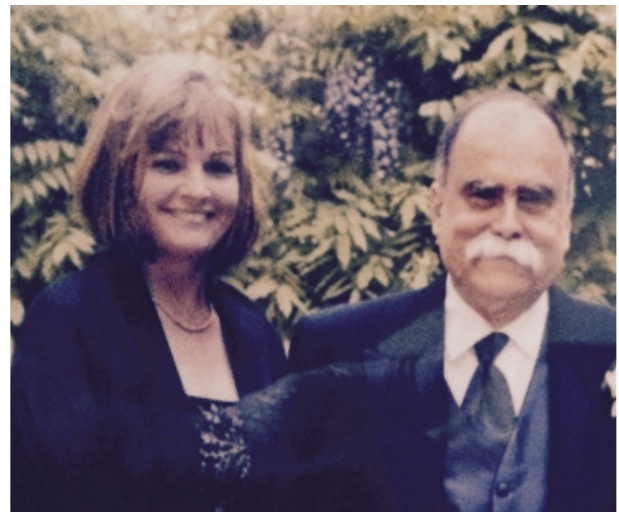
Fig. 15 - Helena and Tomas Salerno enjoying life during social event. They make a wonderful and charming